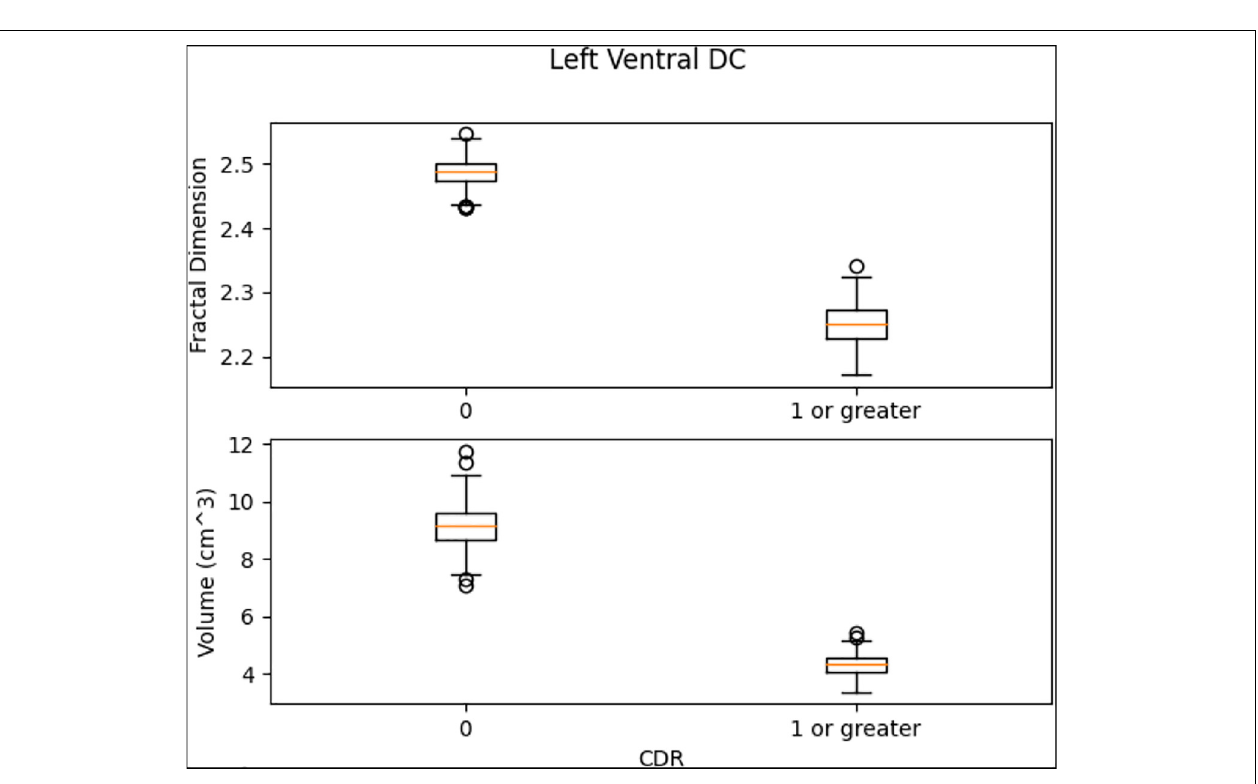
FIGURE 16 | The box plots for Left Ventral DC